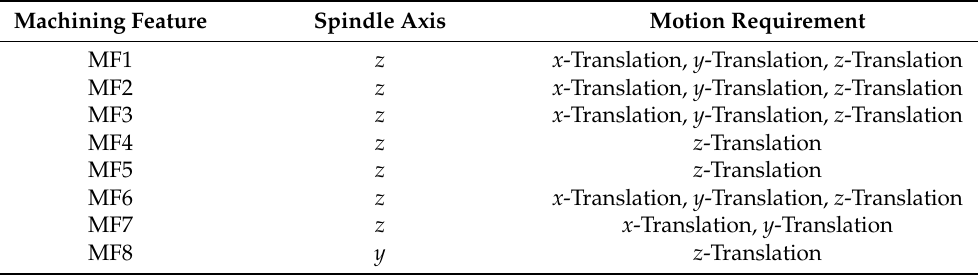
Table 2. Corresponding motion